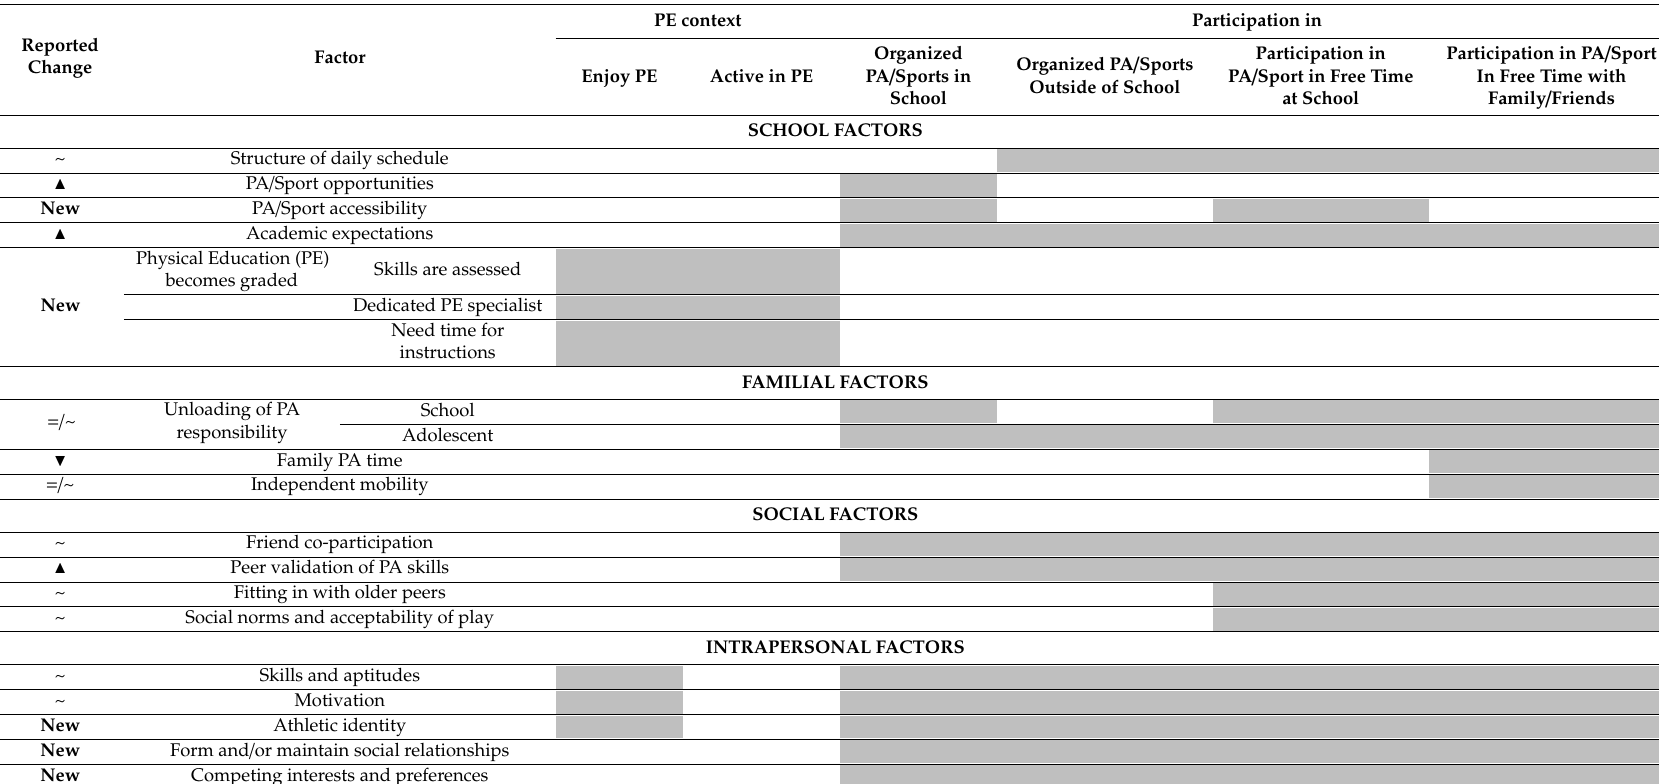
Table 2. Mechanisms through which the transition from elementary to secondary school influences physical activity (PA) in various settings ( n = 27 families). Reported